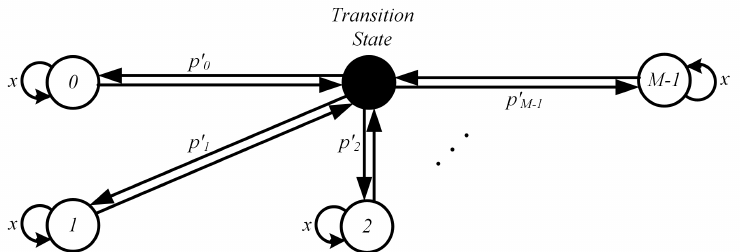
Figure 2. State diagram of the Markov–Middleton class A